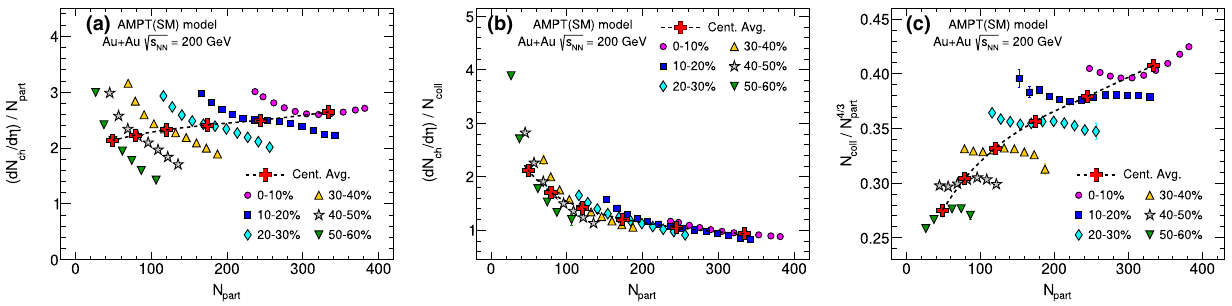
√ s NN = 200 age values are shown by the “ + ” marker in red, whereas the values for L+R binning in each centrality are shown in solid circles of different